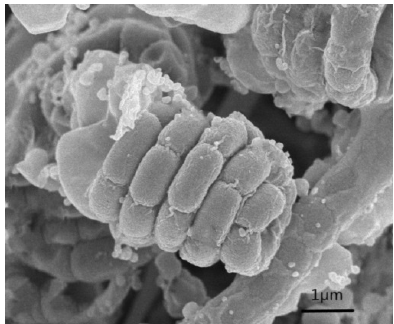
Figure 1. Scanning electron micrograph of strain NEAU-HV9 grown on International Streptomyces Project (ISP) 3 agar for 2 weeks at 28 °C.